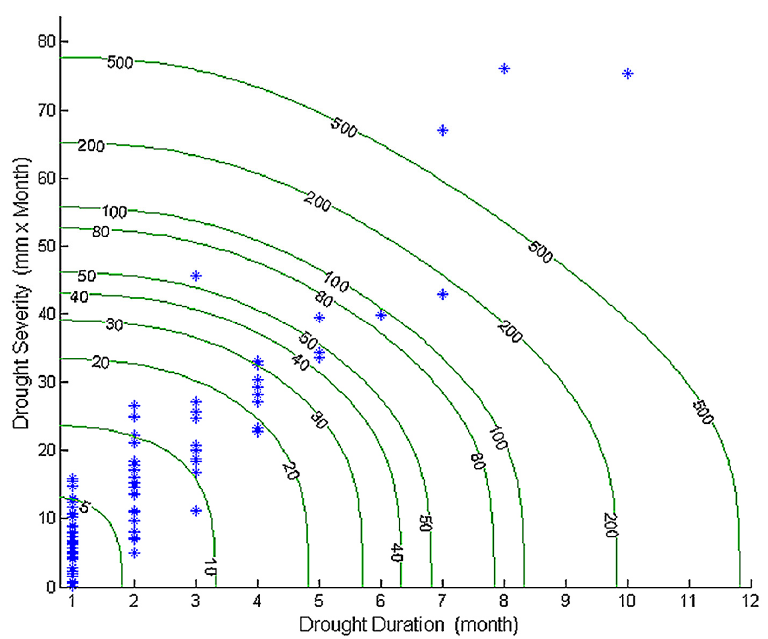
Figure 11. Return period plot for Sacramento River.